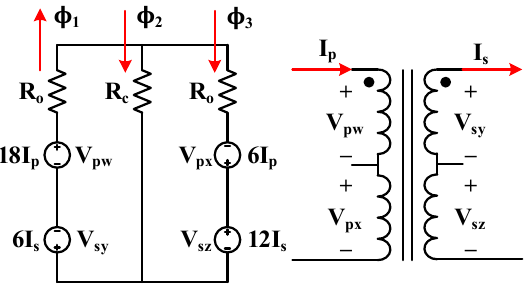
Figure 5. Reluctance model for adjustable leakage inductance.